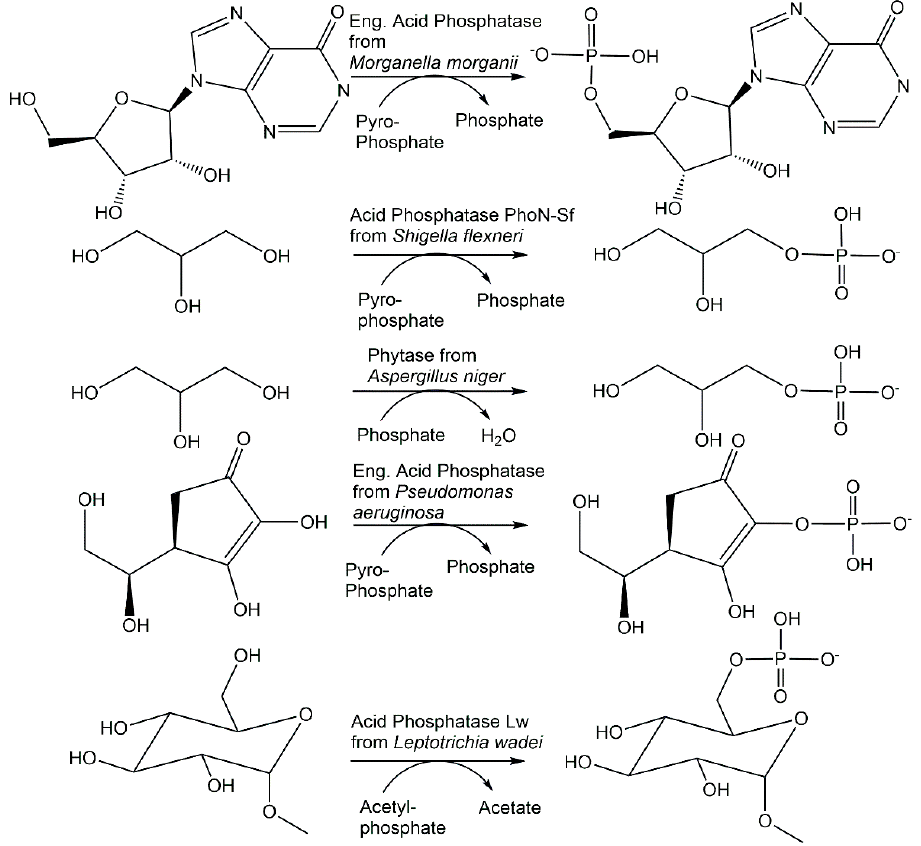
Figure 13. Selected synthetic applications of phosphohydrolases in phosphorylation reactions.